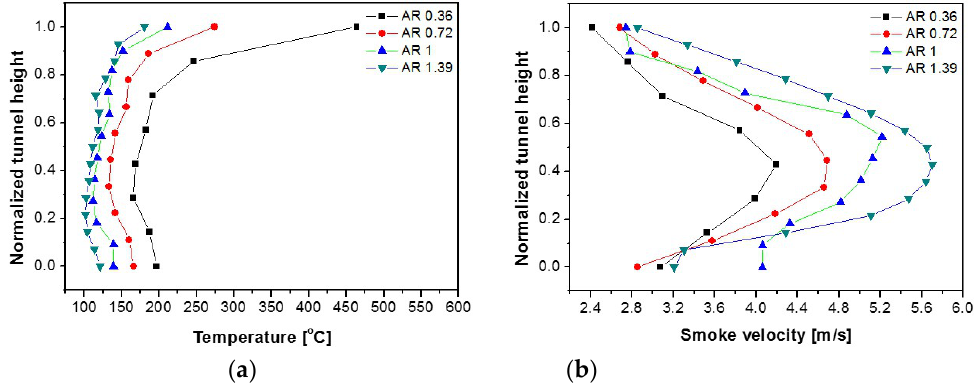
Figure 5. Temperature and smoke velocity distributions where it is located below 0.2 m of ceiling for varying aspect ratio at 1500 s. ( a ) Temperature distribution, ( b ) Smoke velocities.